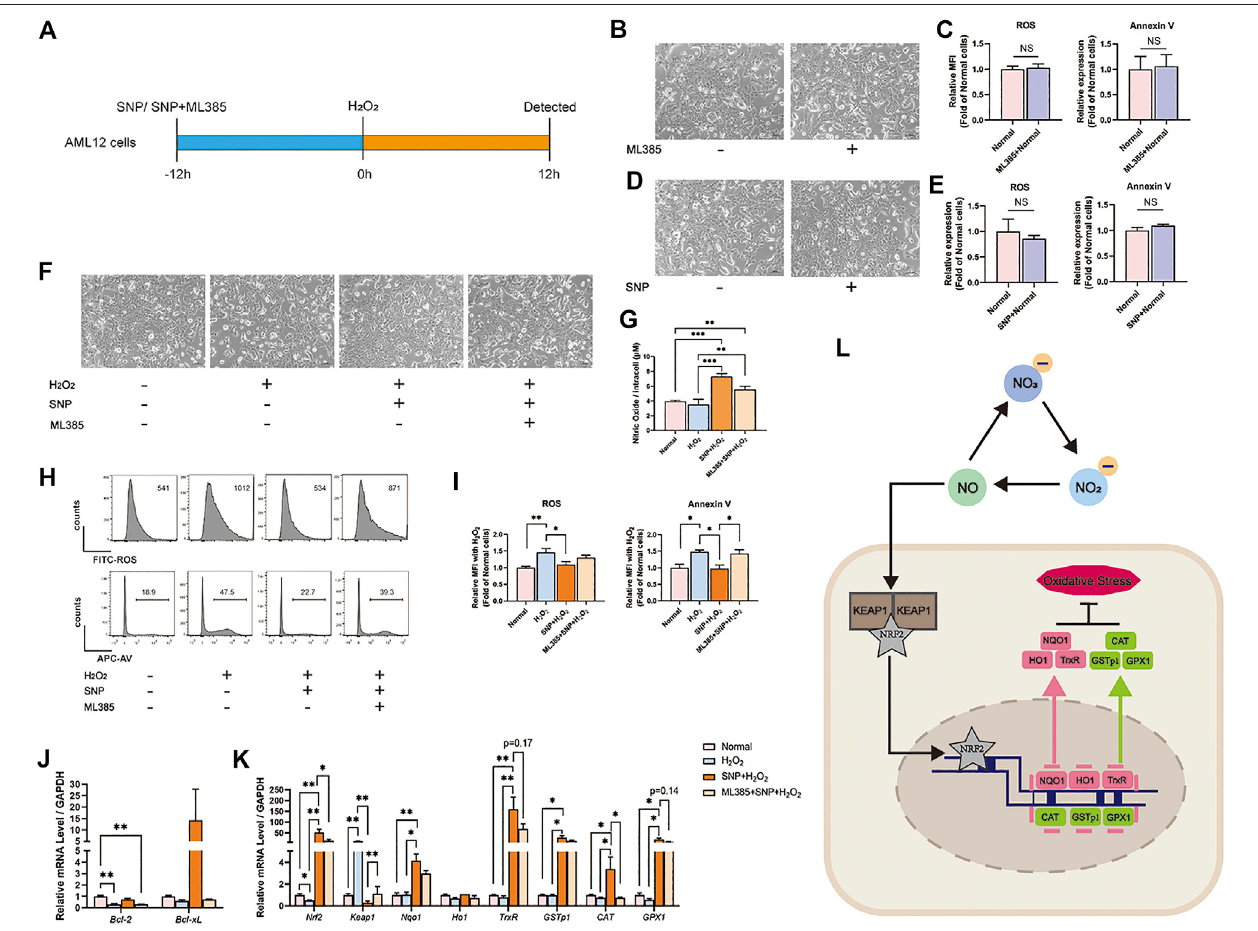
FIGURE 5 | SNP (NO donor) pretreatment attenuated oxidative stress induced by H 2 O 2 and upregulated NRF2 in vitro , while ML385 (NRF2 inhibitor) reversed the protective effect of SNP on H 2 O 2 -stimulated AML12 cells. (A) SNP or SNP + ML385 was administered 12 h before the 12 h stimulation of H 2 O 2 . (B) Morphology of AML12 cells in Normal and Normal + ML385 groups. (C) Relative MFI of ROS, Annexin V, in Normal and Normal + ML385 groups. (D) Morphology of AML12 cells in NormalandNormal+SNPgroups. (E) RelativeMFIofROS,AnnexinV,inNormalandNormal+SNPgroups. (F) MorphologyofAML12cellsinNormal,H 2 O 2 ,SNP + H 2 O 2 , and ML385 + SNP + H 2 O 2 groups. (G) The level of NO in Normal, H 2 O 2 , SNP + H 2 O 2 , and ML385 + SNP + H 2 O 2 groups. (H) Representative fl ow cytometric results of ROS, Annexin V, and (I) statistical analyses. (J) Relative mRNA level of Bcl-2 and Bcl-xL. (K) Relative mRNA level of Nrf2, Keap1, Nqo1, Ho1, TrxR, GSTp1, CAT, and GPX1 in Normal, H 2 O 2 , SNP + H 2 O 2 , and ML385 + SNP +H 2 O 2 groups. (L) Mechanisms by which dietary nitrate protects HIRI. Dietary nitrate isconverted to NO, which is transported through the cell membrane and disintegrates KEAP1 and NRF2. NRF2 is transferred into the nucleus, wherein it activates downstream genes and transcribes related proteins to modulate oxidative stress. Data are expressed as mean ± SEM, *p ＜ 0.05, **p ＜ 0.01, ***p ＜ 0.001, and NS denotes no signi fi cance.